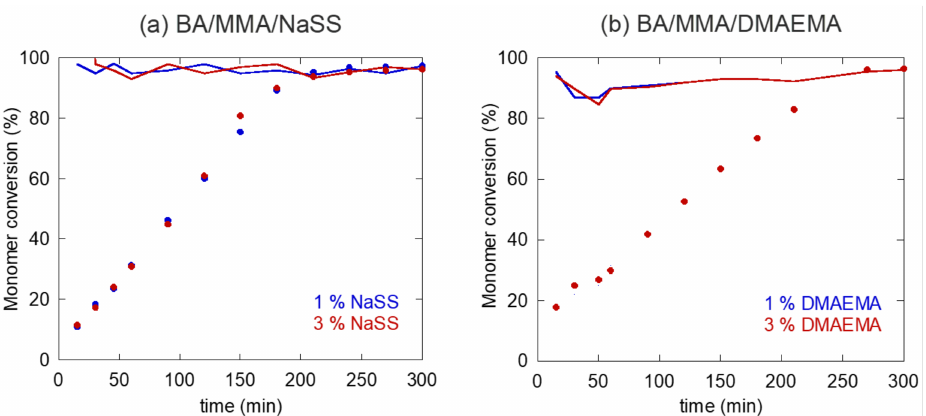
Figure 4. Monomer conversion evolution for latexes ( a ) containing NaSS and ( b ) containing DMAEMA. The continuous line represents the instantaneous conversion, while the dots the overall